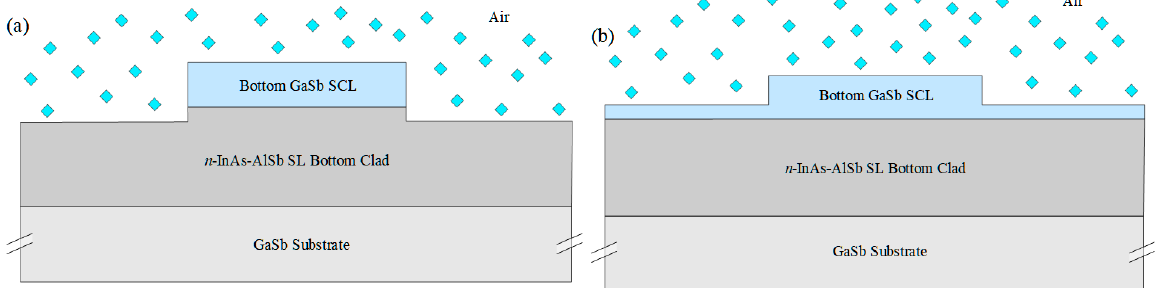
Figure 2. Schematic cross sections of passive waveguides processed from the ICL epitaxial structure of Figure 1a. The ridge is formed by etching away the top contacting layer, top clad layer, top SCL, and the active stages, to leave the bottom SCL that serves as the waveguide core and the bottom InAs-AlSb SL that forms the bottom clad. Outside the narrow ridge, either the bottom SCL is fully etched away, with the etch stopping near the top of the bottom cladding layer ( a ), or the etch stops within the bottom SCL ( b ). If the tops and sides of these passive waveguides are left exposed, as shown in the figures, propagating light will evanescently couple to an ambient sample gas or liquid. A typical overlap of the optical mode profile with the ambient gas will be illustrated